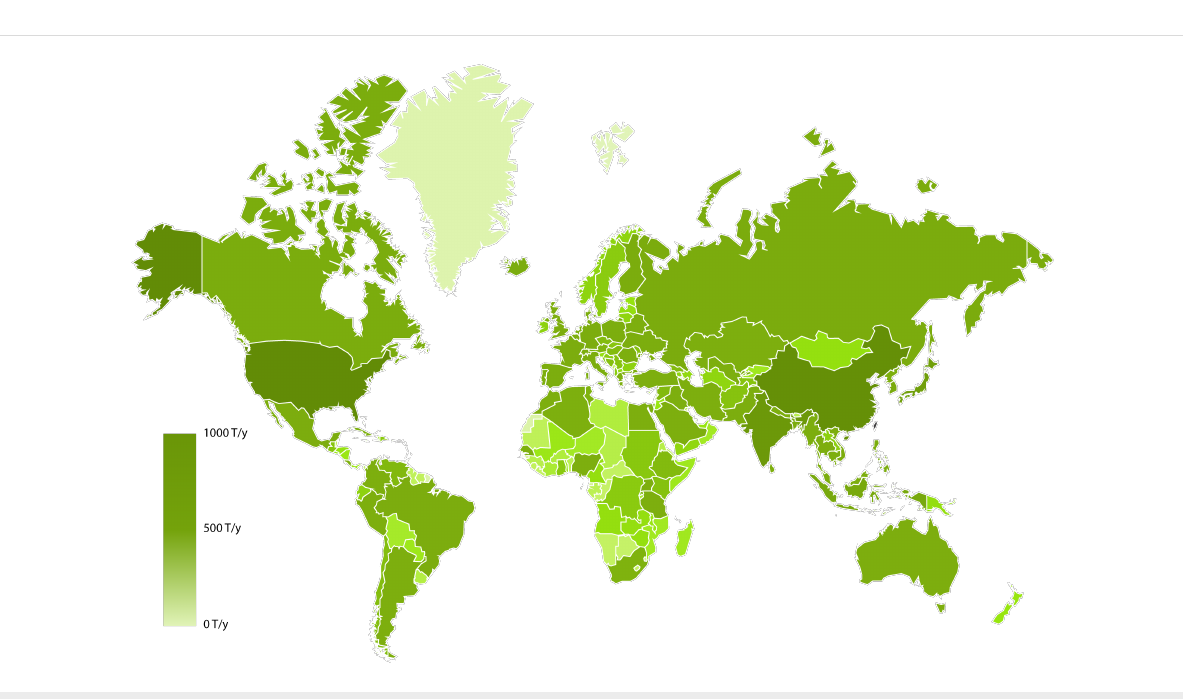
Figure 5: Example of the global distribution of the release rates of TiO 2 into water.